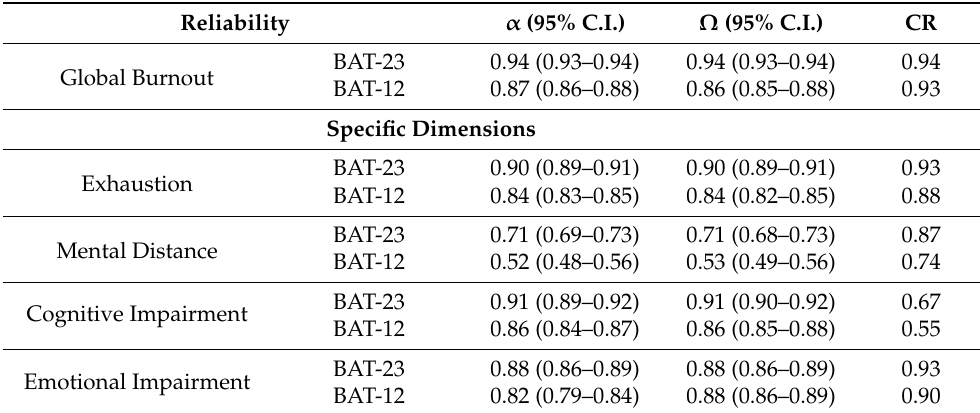
Table 3. Internal consistency